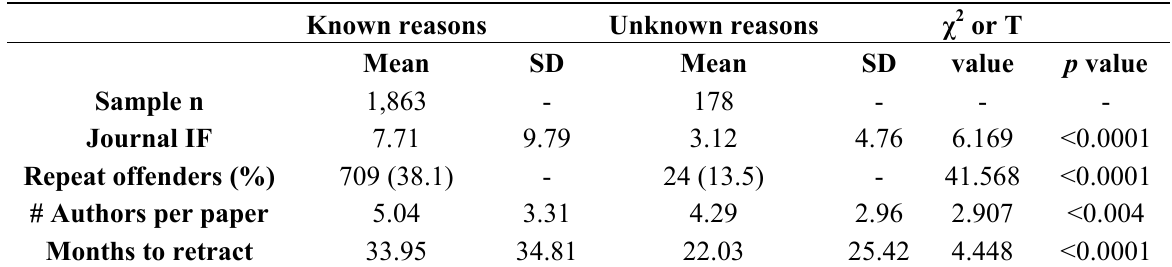
Table 1. Comparison of articles for which a retraction notice was available and the reason for retraction could be determined (“Known”) vs. articles for which no retraction notice was available or the reason for retraction could not be determined (“Unknown reasons”).